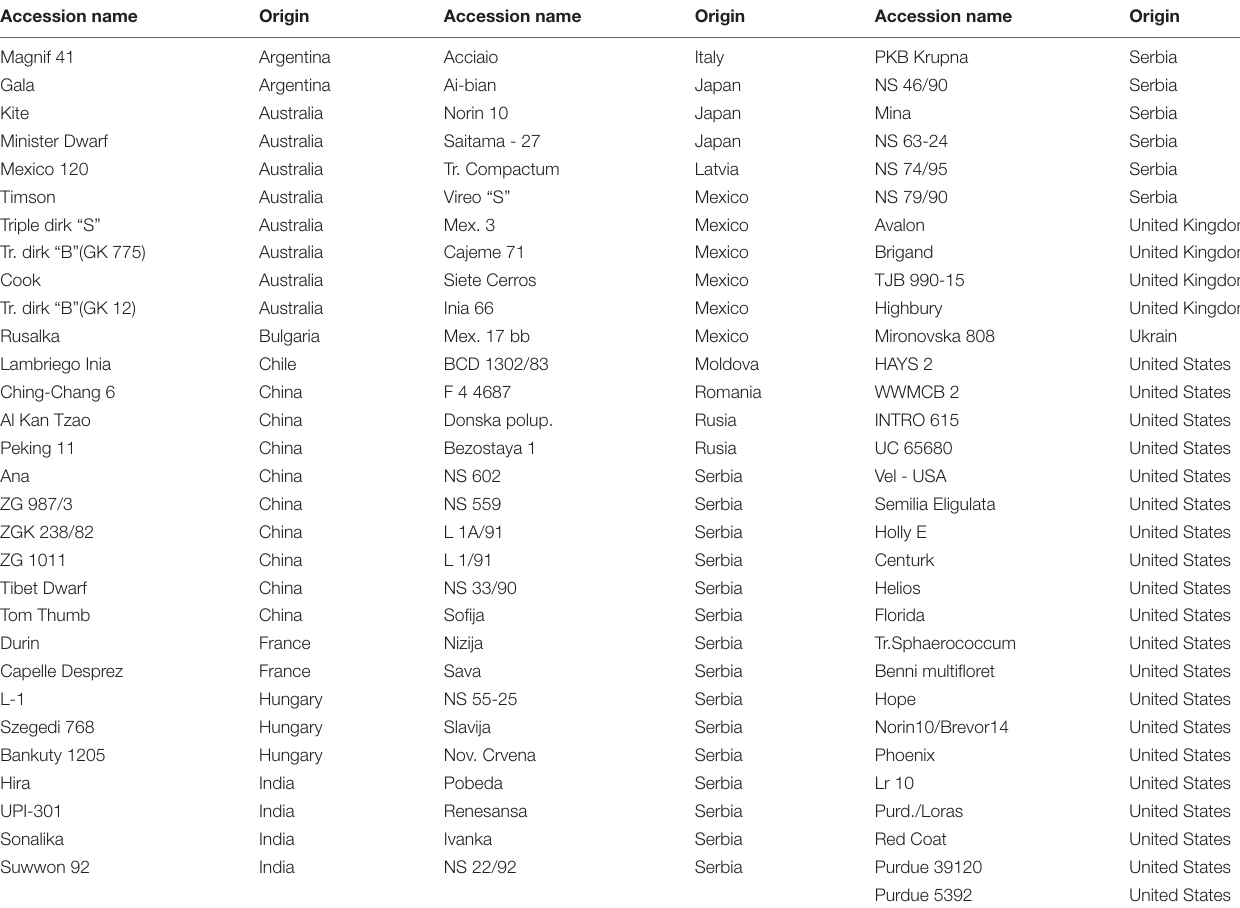
TABLE 1 | Genotypes (91) used in this experiment and their respective countries of